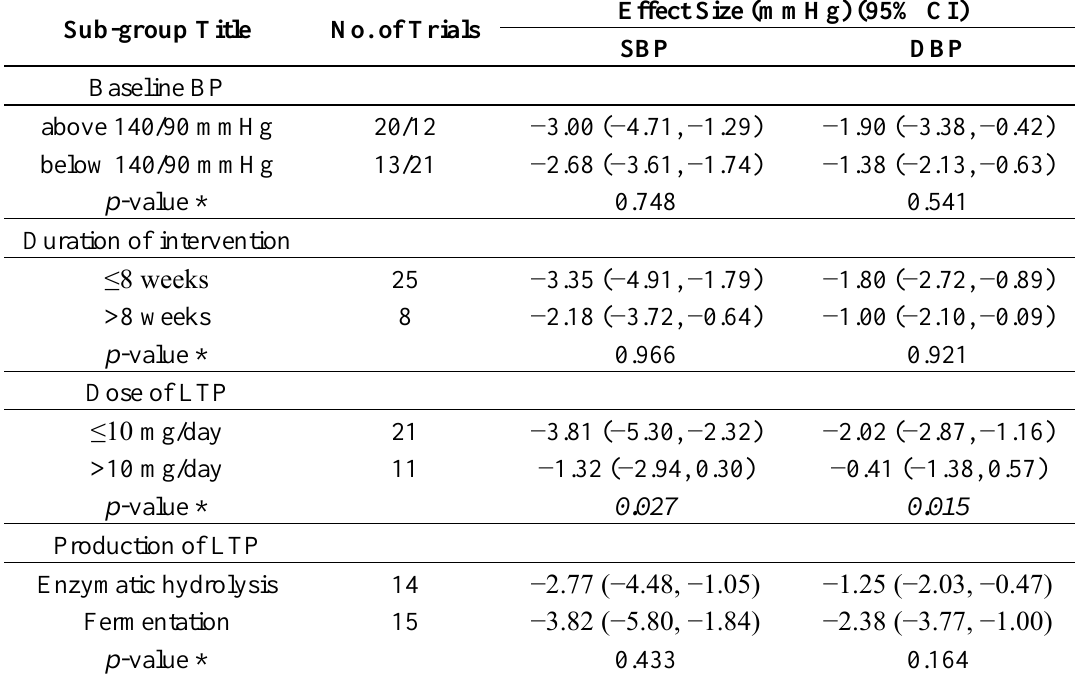
Table 2. Sub-group